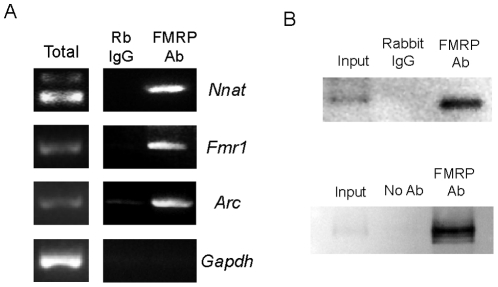

Nnat mRNA associates with FMRP.(A) RNA co-immunoprecipitation (non-UV crosslinked) followed by RT-PCR using FMRP antibody or rabbit IgG for Nnat mRNA. Known FMRP binding targets, Arc and Fmr1, are enriched in the FMRP immunoprecipitated sample, whereas Gapdh, a non-target, is not. Based on product size, Nnatβ was the predominant FMRP-binding isoform. RT-PCR using total hippocampal RNA is shown in the left column. (B) FMRP immunoprecipitation efficiency was tested using 2.5% input or immunoprecipitated hippocampal protein, probed with FMRP antibody and compared to rabbit IgG or no antibody.